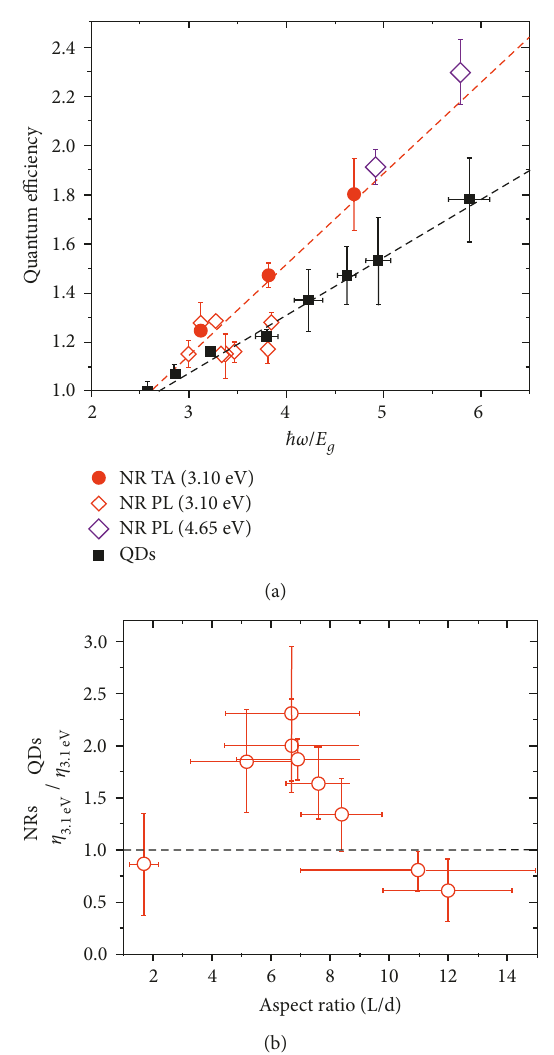
Figure 7: Adapted from [59]. (a) QYs measured for a range of nanorods of different aspect ratios and bandgap energies com- pared against the same range of results for quantum dots. The data for the quantum dots are from [27, 62]. (b) Carrier multiplication enhancement factor for nanorods against QDs as a function of aspect